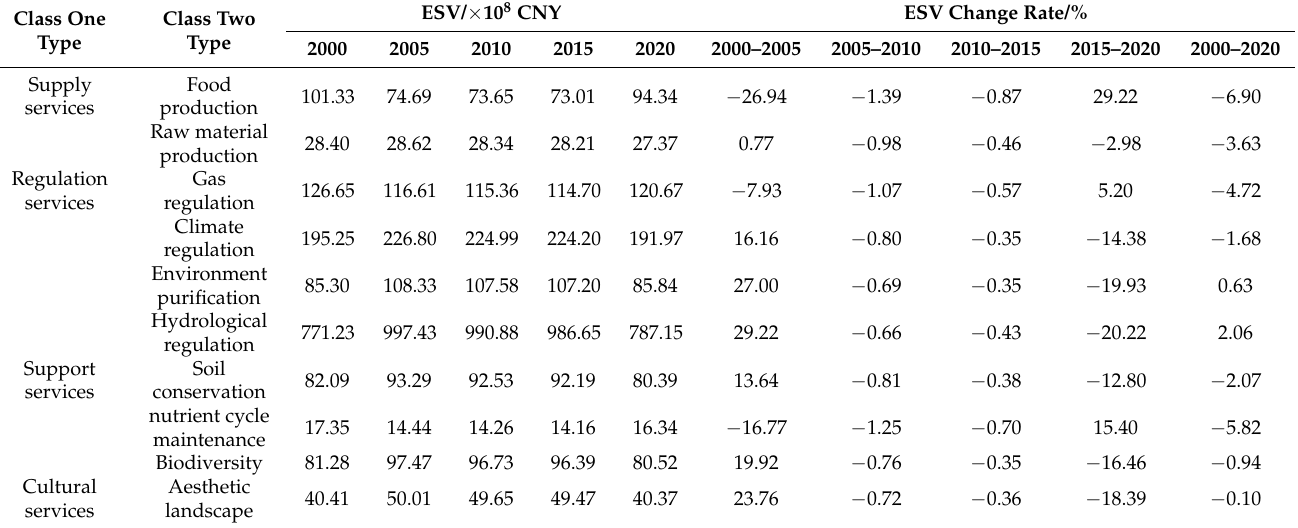
Table 3. Changes of individual ESV in the Nanjing metropolitan